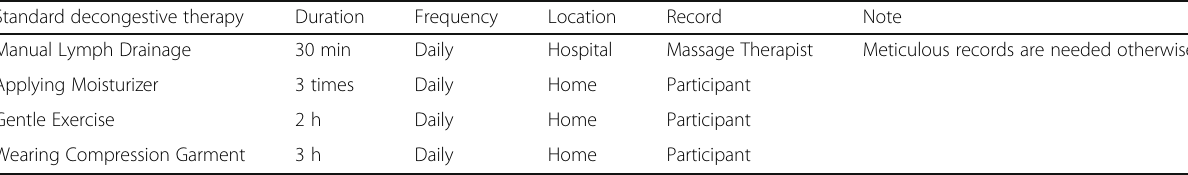
Table 2 Overview of standard decongestive therapy contents Standard decongestive